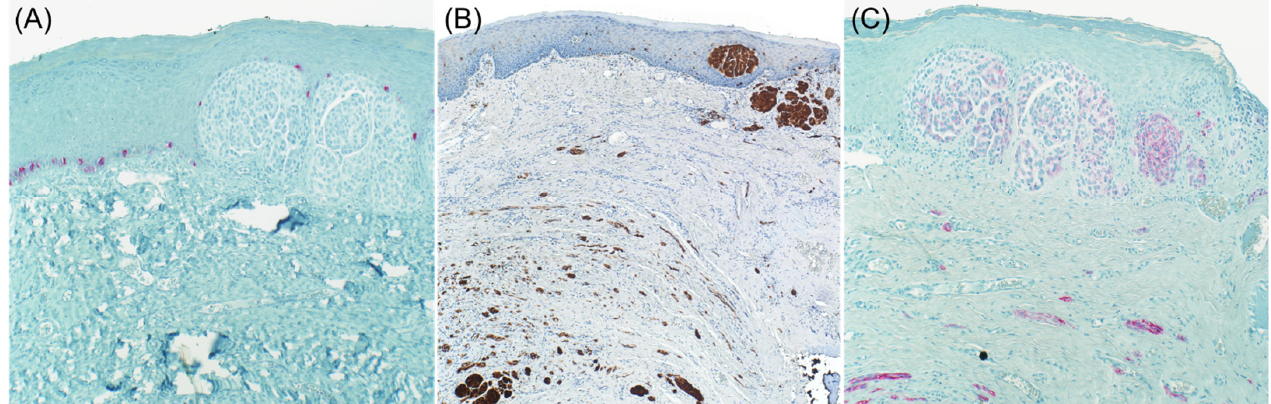
Figure 2. Desmoplastic melanoma. Lesional cells are negative for Mart-1 ( A , immunohistochemical stain 10) and positive for S100 ( B , immunohistochemical stain 4) and NGFR ( C , immunohistochemical stain 10).